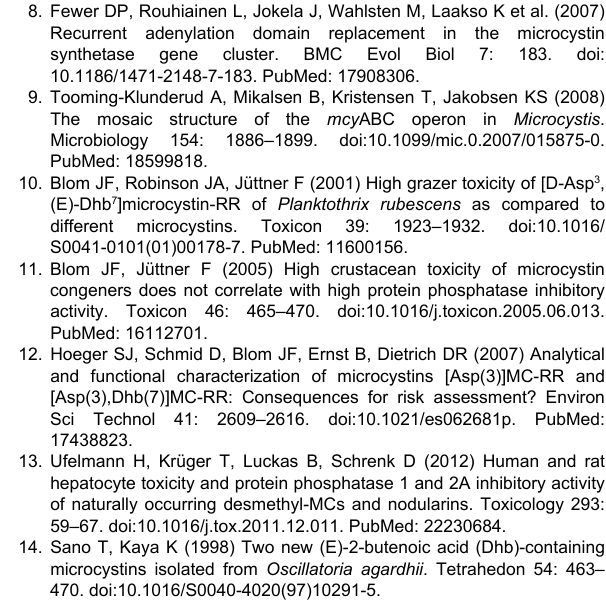
Table S1. Oligonucleotide primers used to amplify the target regions for qPCR from heat-desiccated DNA samples. Table S2. Influence of heat-desiccation of Planktothrix cells on qPCR quantification. Table S3. Average ± SE biovolume per year of the total Planktothrix population, and biovolume and proportions of mcy genotypes in Lake Zürich between 1977 and 2008. Figure S1. DNA isolated from heat-desiccated vs. frozen phytoplankton samples obtained from Lake Zürich. Figure S2. Ct values (mean ± SE) as determined by qPCR using four different gene loci of Planktothrix (16S rDNA, Dhb, Mdha and Hty genotype) from heat-desiccated DNA and treated heat-desiccated